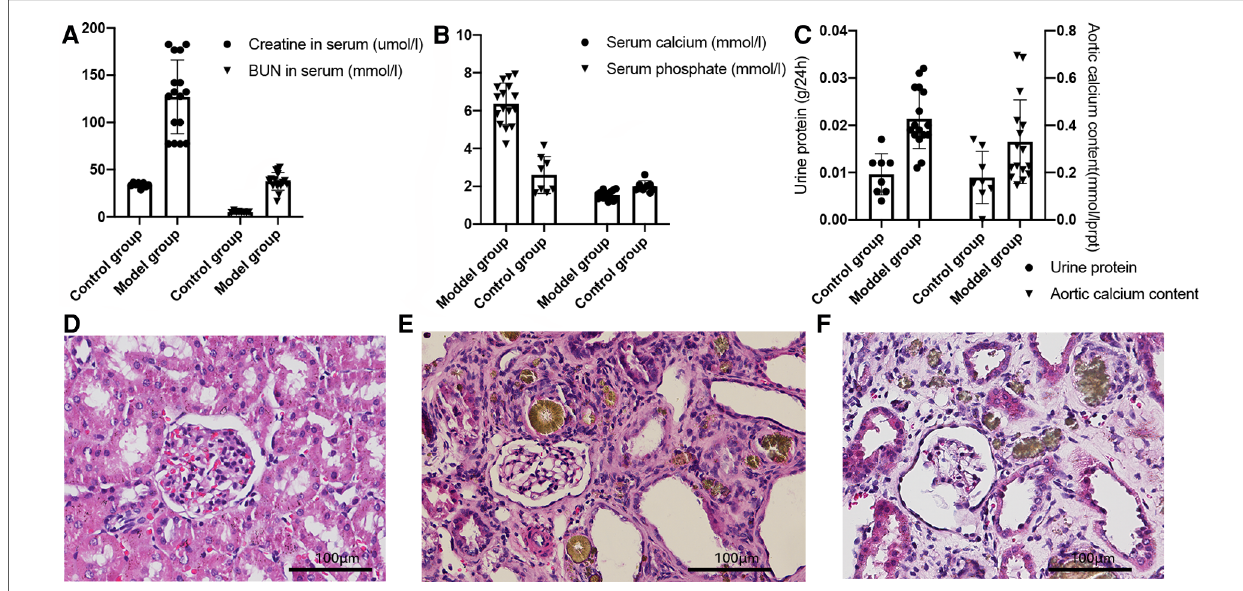
FIGURE 1 Biochemical indices of the animals analyzed by the Student ’ s t -test. ( A ) Serum creatinine and blood urine nitrogen levels, P <0.01. ( B ) Serum calcium and phosphate concentrations, P <0.01. ( C ) 24-hour urine protein level (left, P <0.01) and calcium content of the aortas (right), P <0.01. ( D – F ) Kidney HE stains of the control group ( D ), non-VC group ( E ), and the VC group ( F